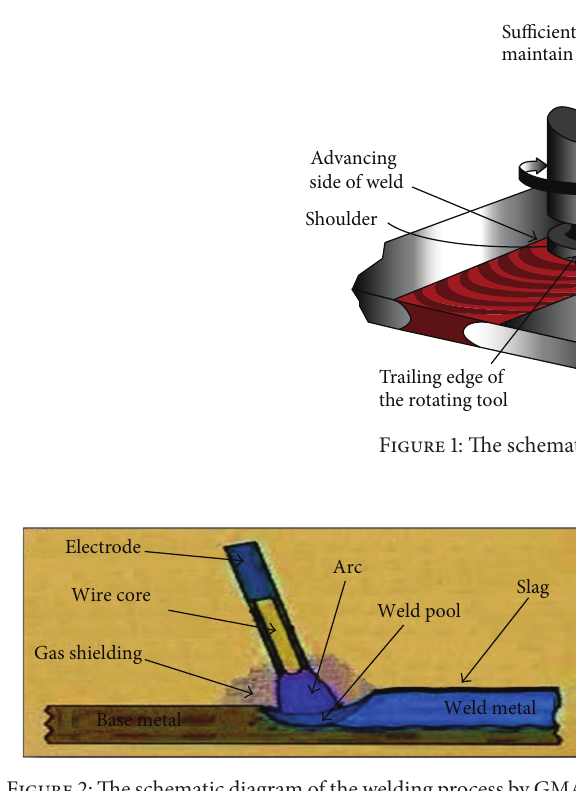
Figure 2: The schematic diagram of the welding process by GMAW. Figure 3: Photograph of the clamped Al strips.